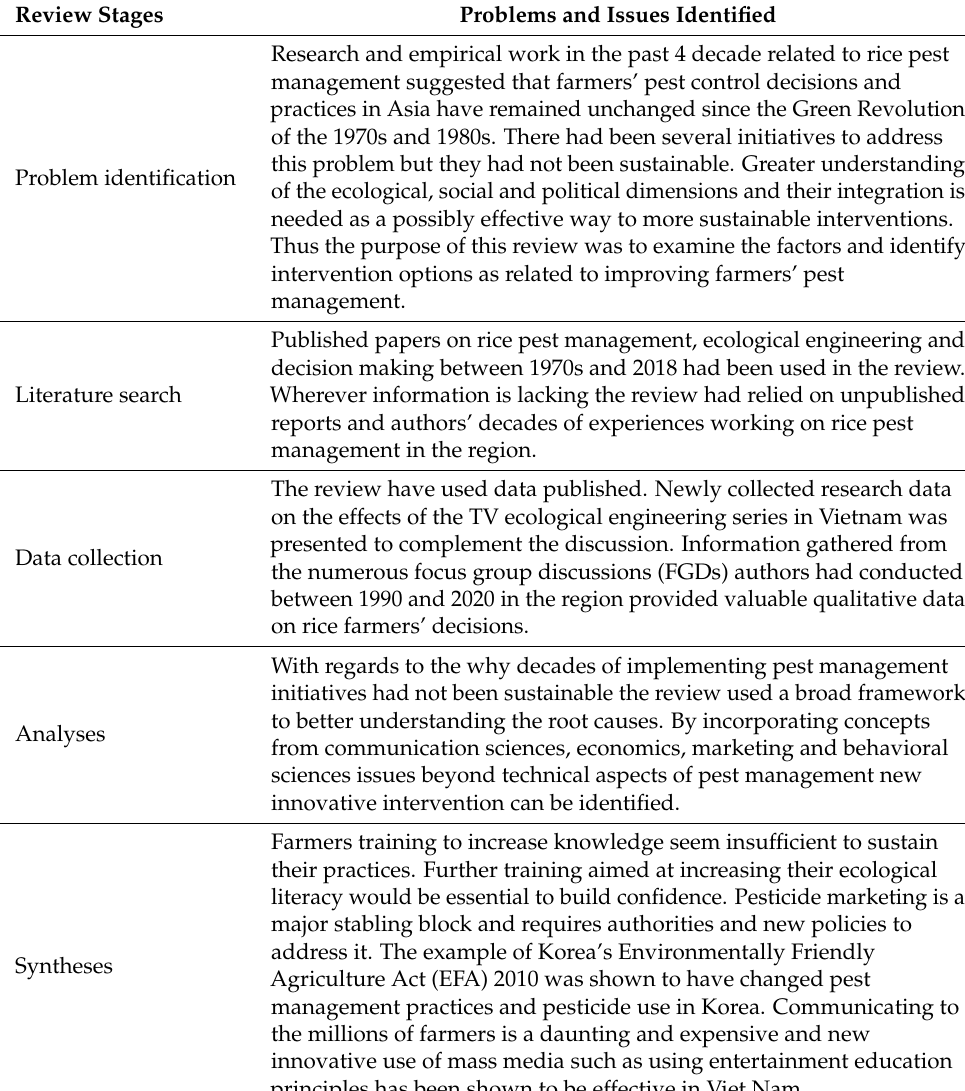
Table 1. Review stages with related problems and issues